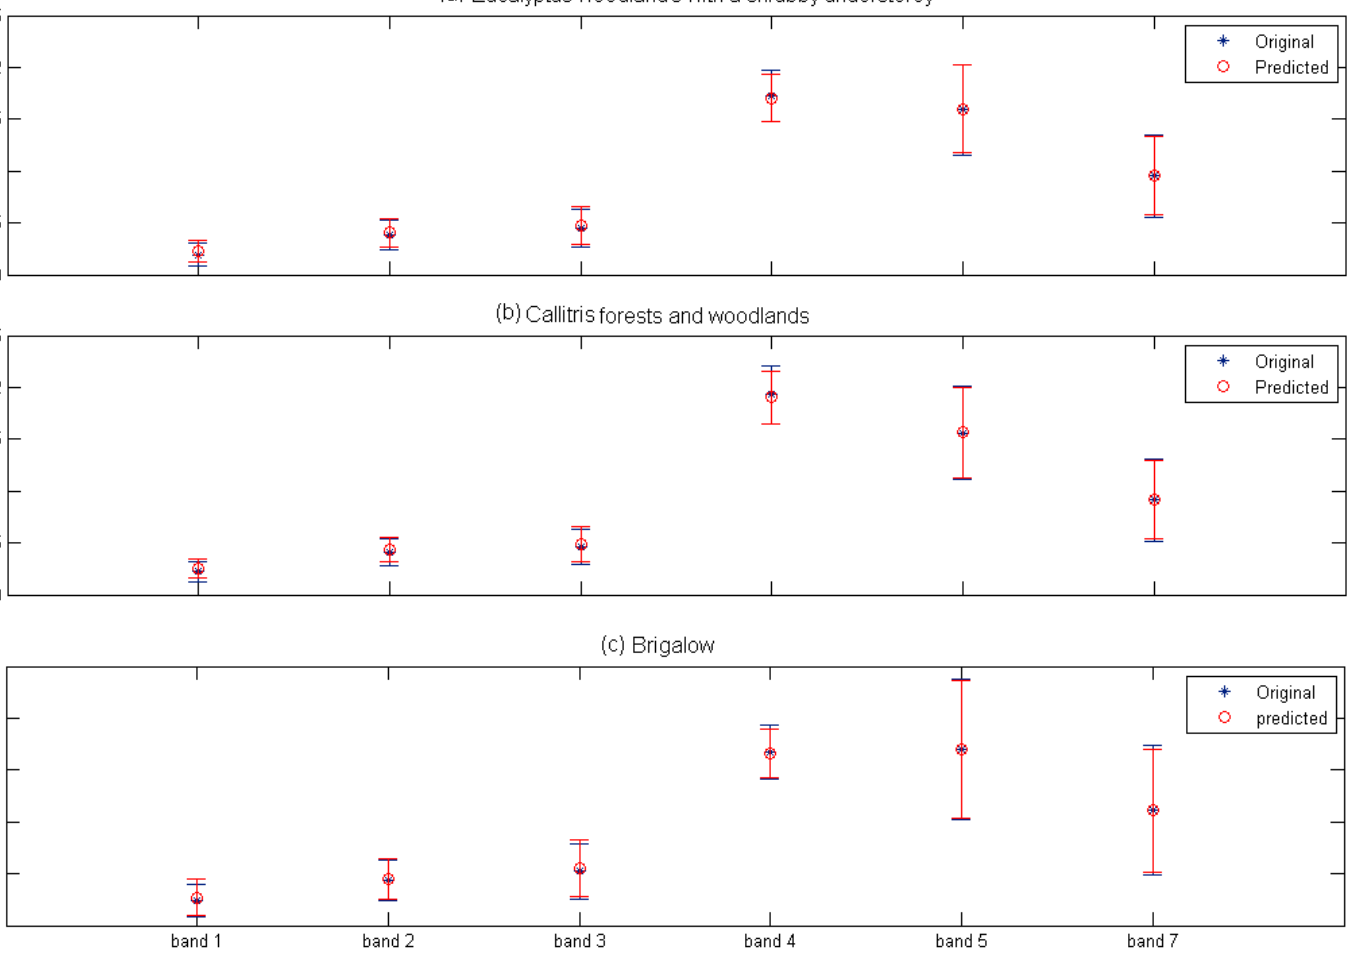
Figure 5. Mean and standard deviation of the Landsat TM spectral band reflectance values for original and predicted Landsat TM image of 2006/06/25 in ( a ) Eucalyptus woodlands with shrubby understory ( b ) Callitris forests and woodlands and ( c ) Brigalow. Similar results were found across all vegetation communities and these three were presented as an